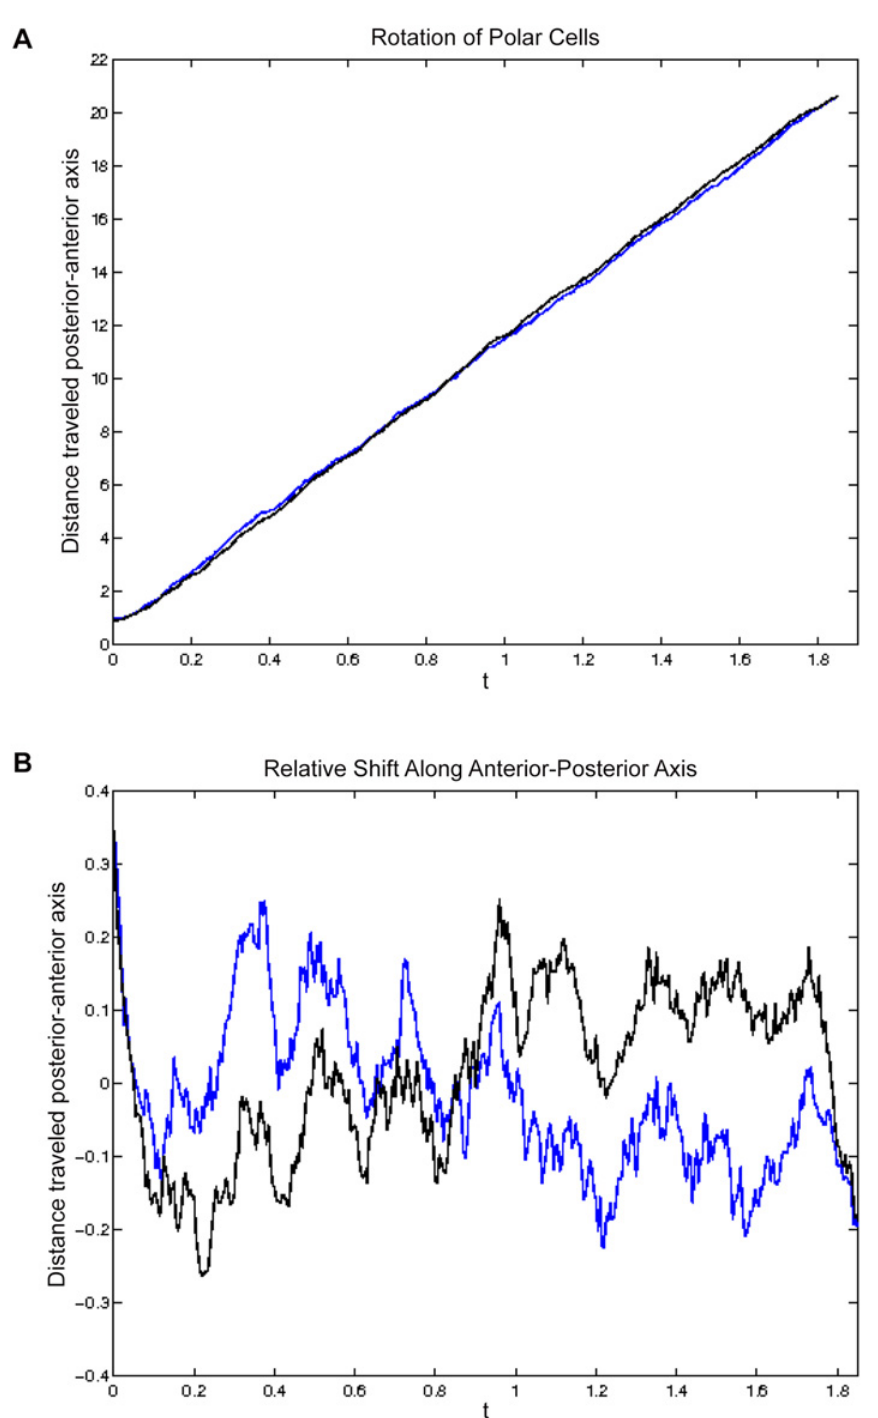
Fig 4. Polar cell positions along main axis of migration. (A) The distance of the polar cells from the anterior of the egg chamber versus time. (B) The relative positions of the two polar cells to one another, along the axis that runs from anterior to posterior through the egg chamber. Each line corresponds to one of the polar cells. As the cluster moves forward, we observe that the polar cells are changing position with respect to one another along this axis, including a complete switch at 0.8 hours. This simulation modeled six border